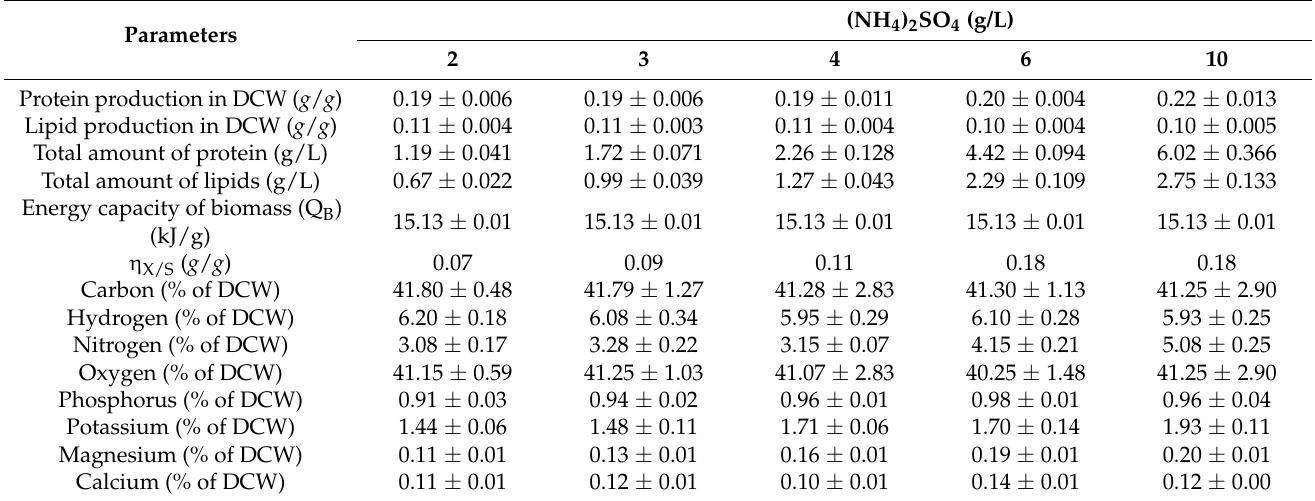
Table 3. The effect of nitrogen concentration on the composition of Y. lipolytica VKM Y-2373